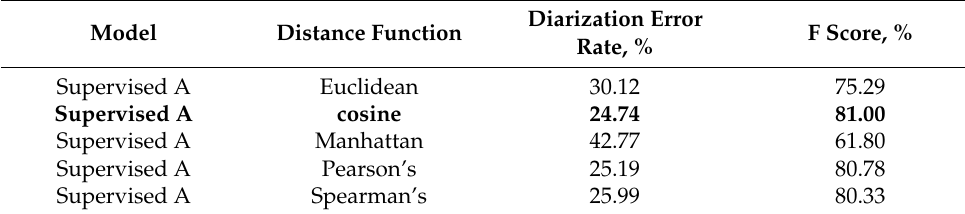
Table 1. Experiment 1